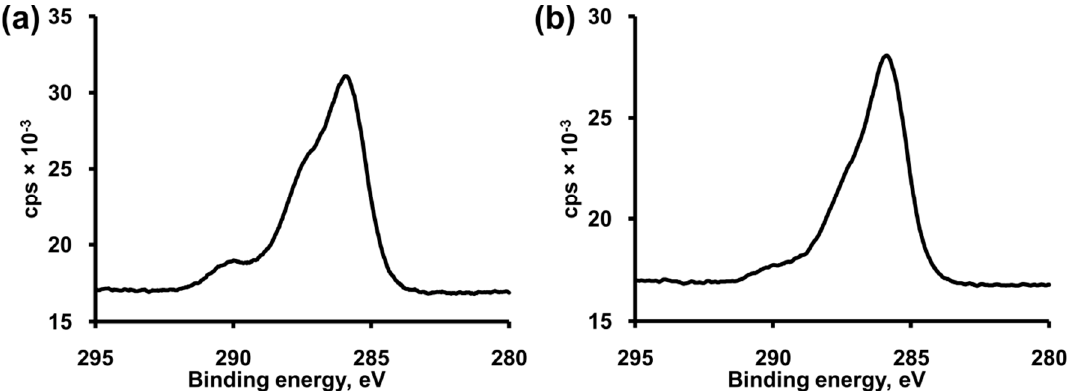
Figure 4. XPS spectra recorded over the C 1s region of the BocAPS-modified SiO 2 surface ( a ) and BocAPS-modified SiO 2 surface with removed Boc groups ( b ).